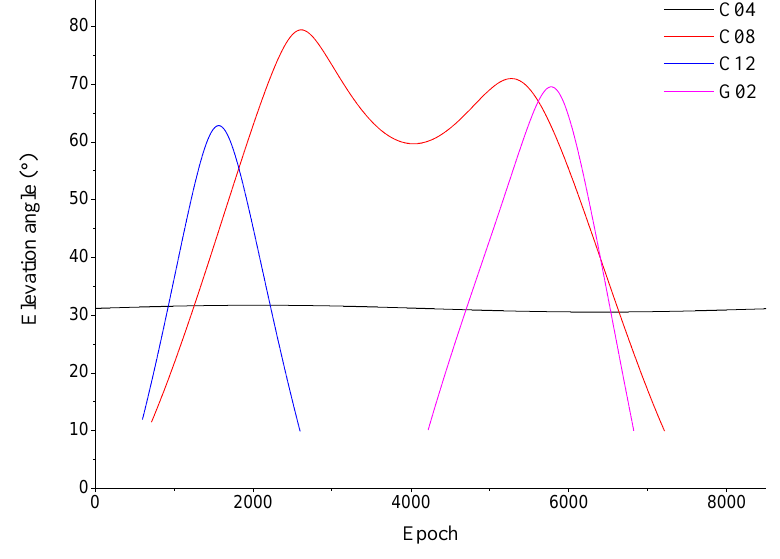
Figure 1. Elevation angle change in a single day.